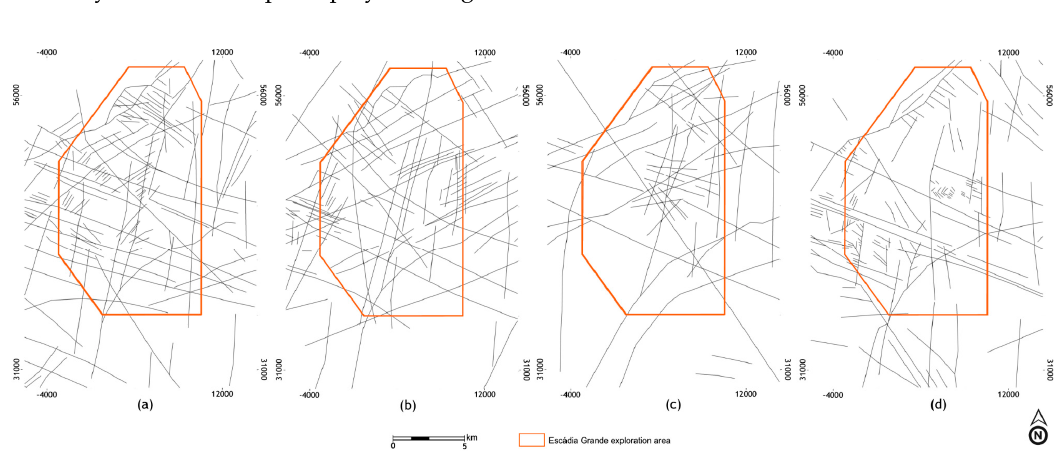
Figure 10. Preliminary lineament mapping based on: ( a ) Landsat 8 (RGB colour composites); ( b ) Landsat 8 (directional filters—OLI band 6); ( c ) Landsat 8 (directional filters—band ratios) and ( d ) Hill shade relief maps.